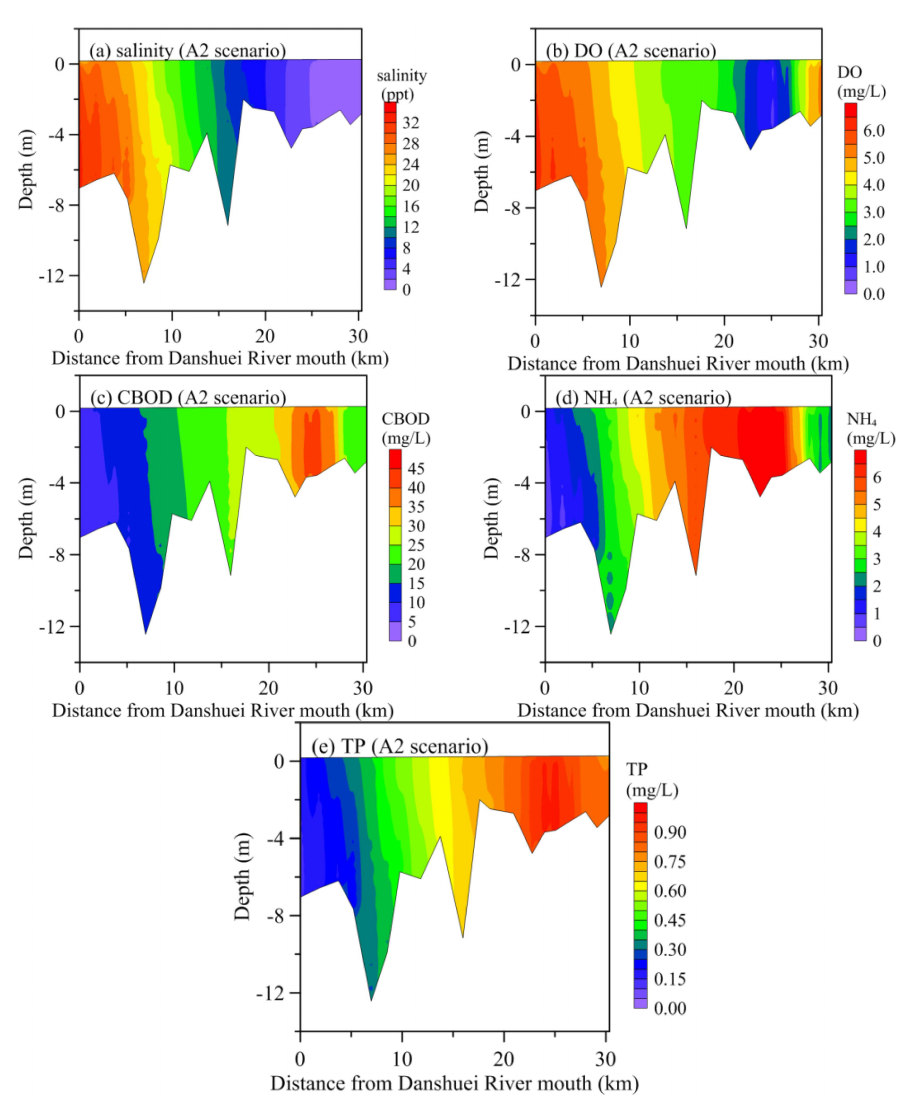
Figure 12. The vertical distribution of the monthly average water quality concentration in the Danshuei River to Tahan Stream under Q75 flow for the A2 Scenario ( a ) Salinity; ( b ) DO; ( c ) CBOD; ( d ) NH4; and ( e )